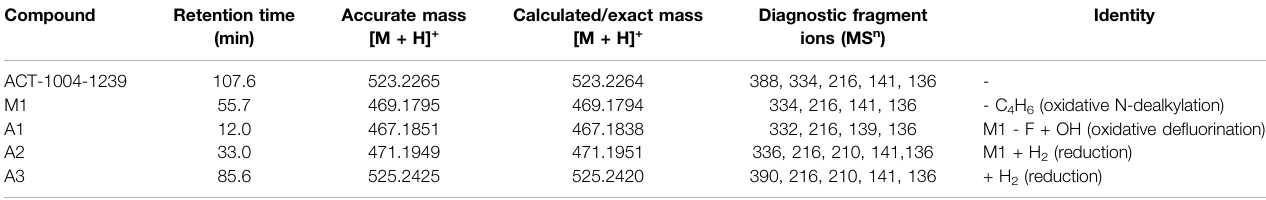
TABLE 4 | Mass spectrometric identi fi cation of ACT-1004-1239 and its metabolites in human feces.